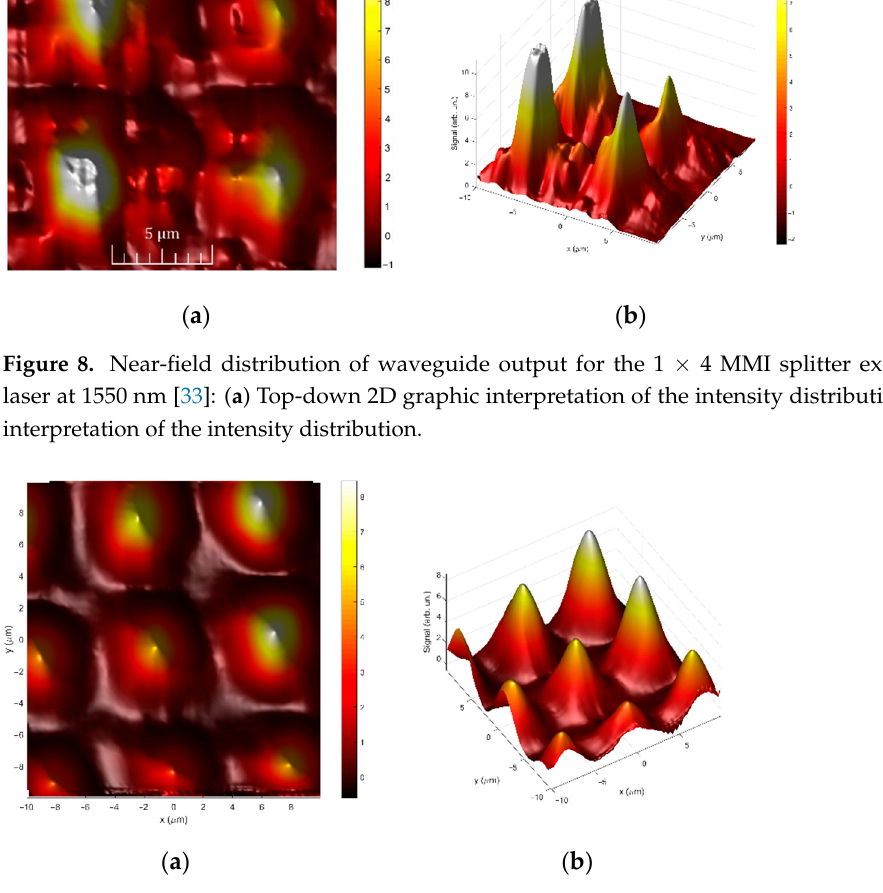
Figure 9. Near-field distribution of waveguide output for the 1 × 9 MMI splitter excited by a laser at 1550 nm: ( a ) Top-down 2D graphic interpretation of the intensity distribution; ( b ) 3D interpretation of the intensity distribution.